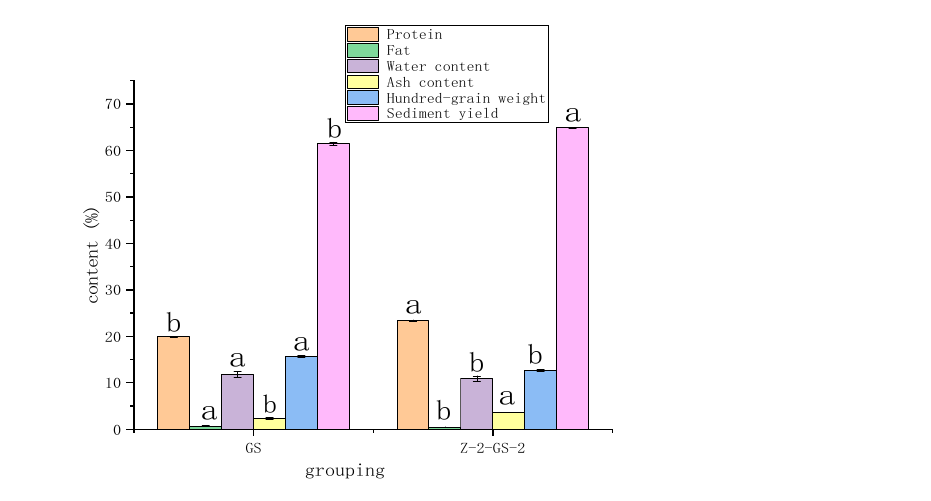
Figure 2. FSA’s effect on protein, fat, water content, ash Content, hundred-grain weight, and sand yield of Vigna angularis in GS and Z-2-GS-2 Groups. Note: the GS group represents Vigna angularis without the spraying of FSA; the Z-2-GS-2 group represents Vigna angularis under FSA stress. Bars (mean ± SE; n = 3) followed by different alphabets significantly differ ( p ≤ 0.05) among the treatments as per SPSS.